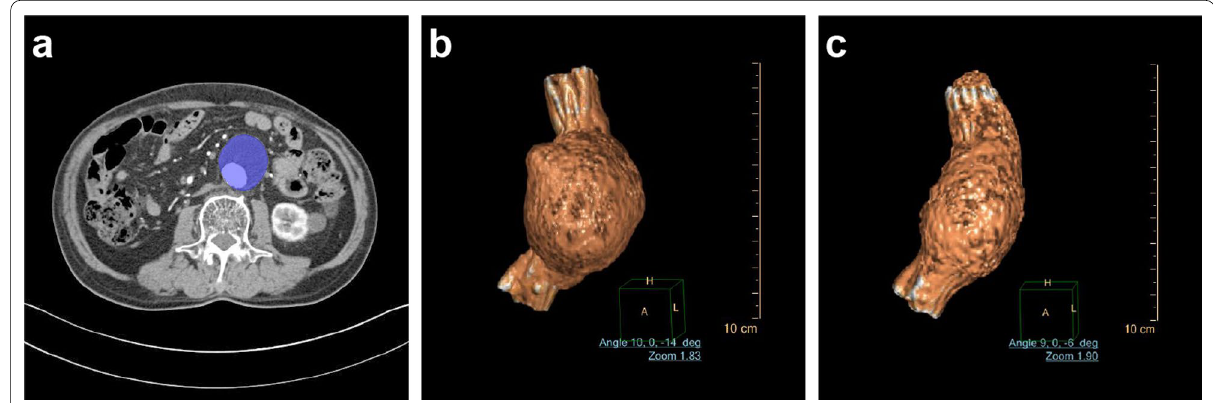
Fig. 2 Traditional imaging evaluation. a Maximal axial plane of the abdominal aortic aneurysm (the blue area). b , c Reconstruction and volume measurement of the aneurysm based on the first and the second postoperative follow-up CT